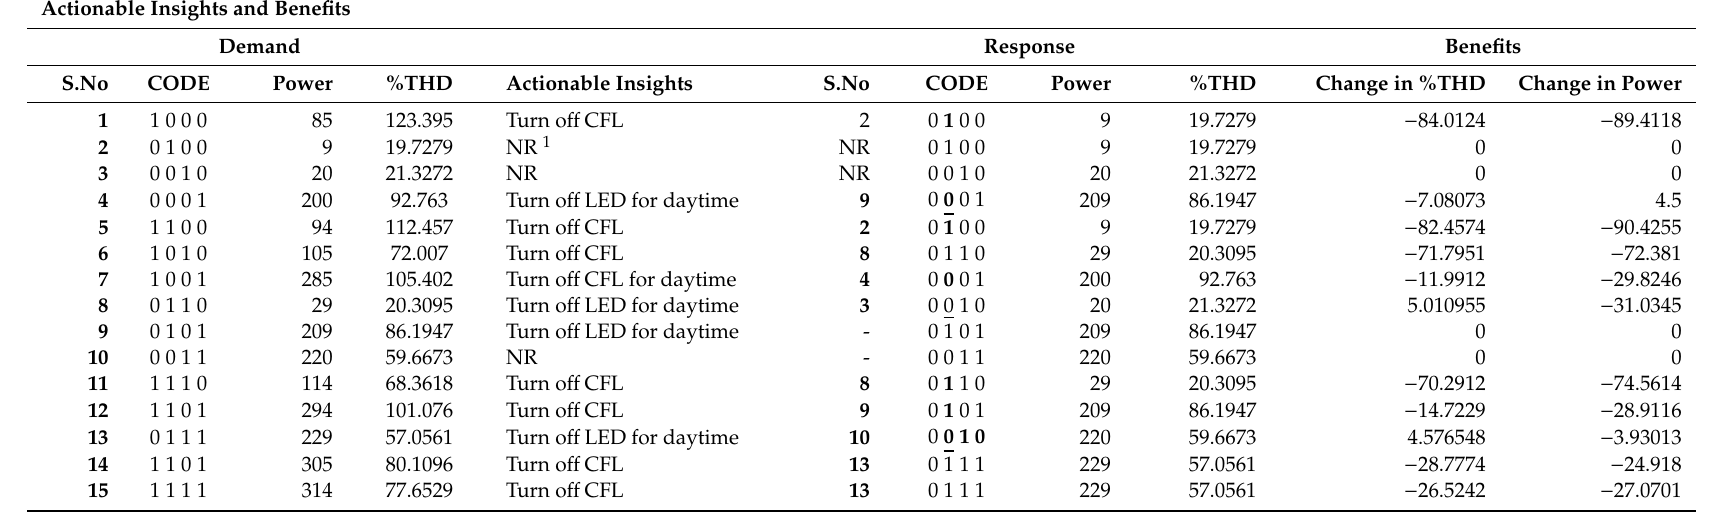
Table 3. Actionable insights for DR